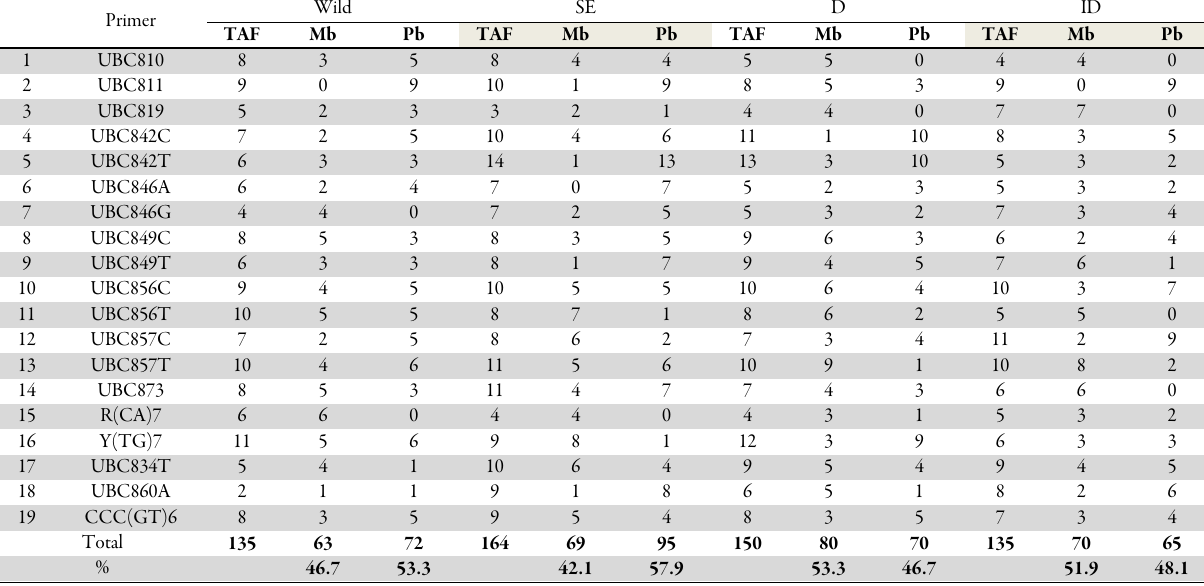
Table 1. ISSR analysis within W=Wild, SE= Somatic embryogenesis, D= Direct regeneration and ID = Indirect regeneration genotypes. TAF= Total amplified fragments, Mb= Monomorphic bands, Pb= Polymorphic bands